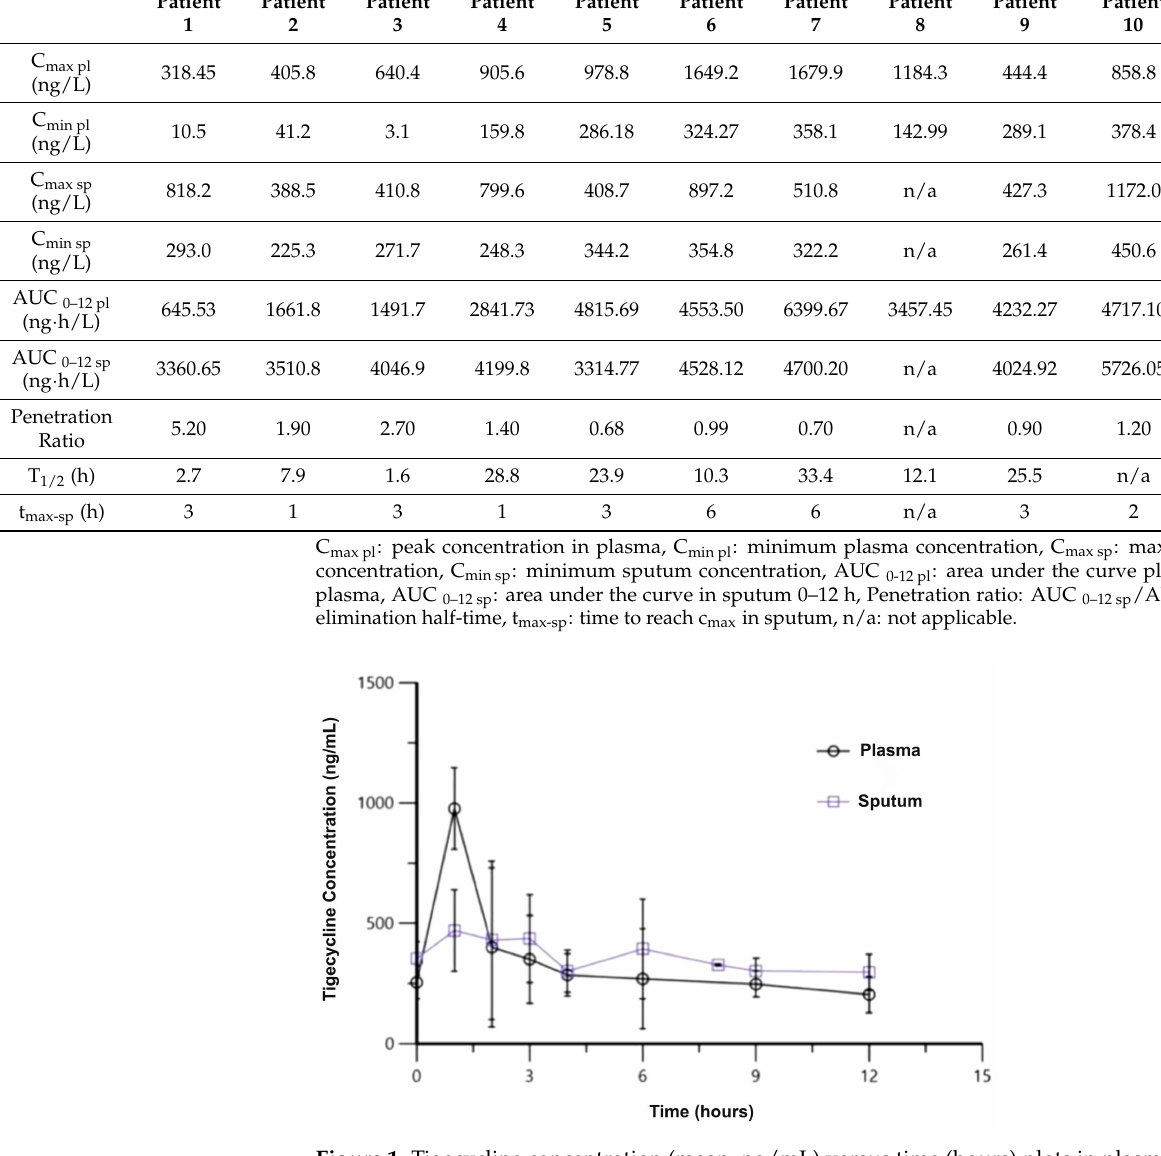
Figure 1. Tigecycline concentration (mean, ng/mL) versus time (hours) plots in plasma (circles) and sputum (squares) after the 7th administration of tigecycline standard dosage regimen to 11 patients hospitalized due to an acute COPD